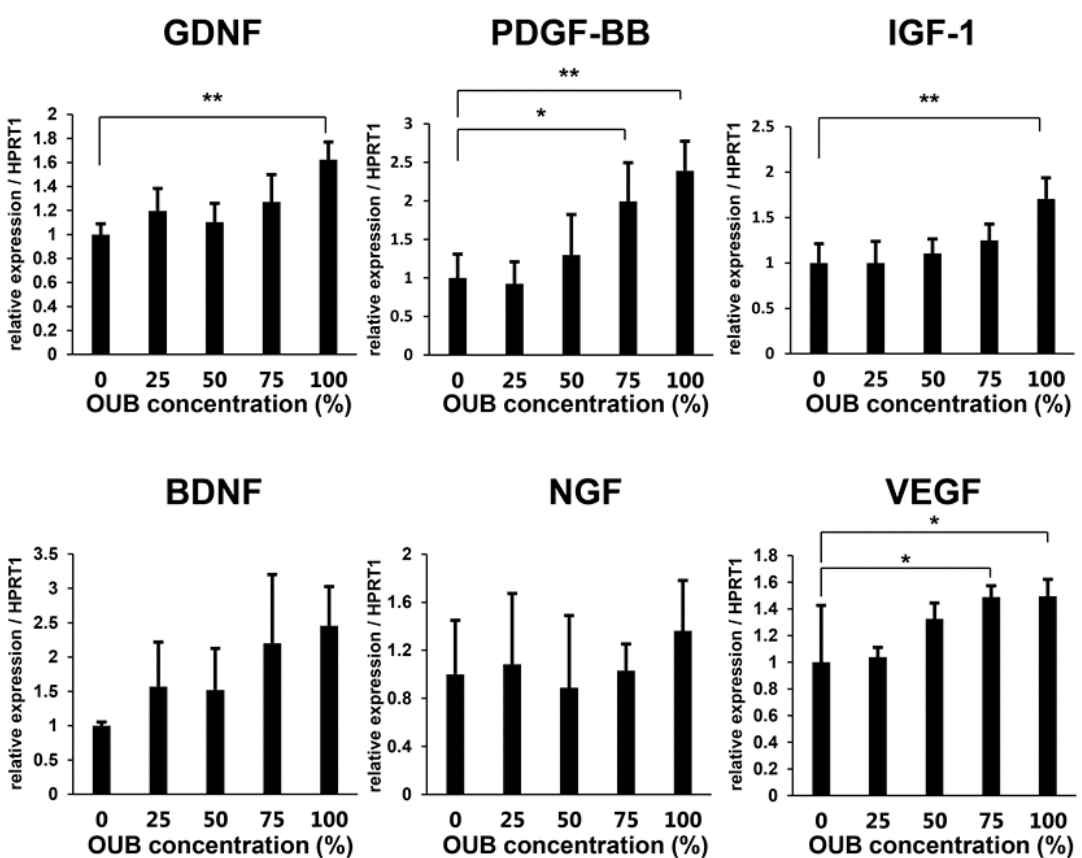
Figure 5. OUBs induce the expression of regeneration-related factors in SCs. Change in gene expression for regeneration-related factors (GDNF, PDGF-BB, IGF-1, BDNF, NGF, and VEGF) were examined using SCs cultured in OUBs diluted in medium (concentration 0, 25, 50, 75, and 100%). HPRT1 was used as an internal control. The data were analyzed by one-way ANOVA followed by a Dunnett test. Graphs show mean ± SD. Results are representative of three independent experiments. * p < 0.05, ** p < 0.01 compared with 0% group. OUBs: oxygen ultra-fine bubbles, SCs: Schwann cells, GDNF: glial cell-derived neurotrophic factor, PDGF-BB: platelet-derived growth factor-beta, IGF-1: insulin-like growth factor-1, BDNF: brain-derived neurotrophic factor, NGF: nerve growth factor, VEGF: vascular endothelial growth factor, HPRT1: hypoxanthine phosphoribosyltransferase 1.